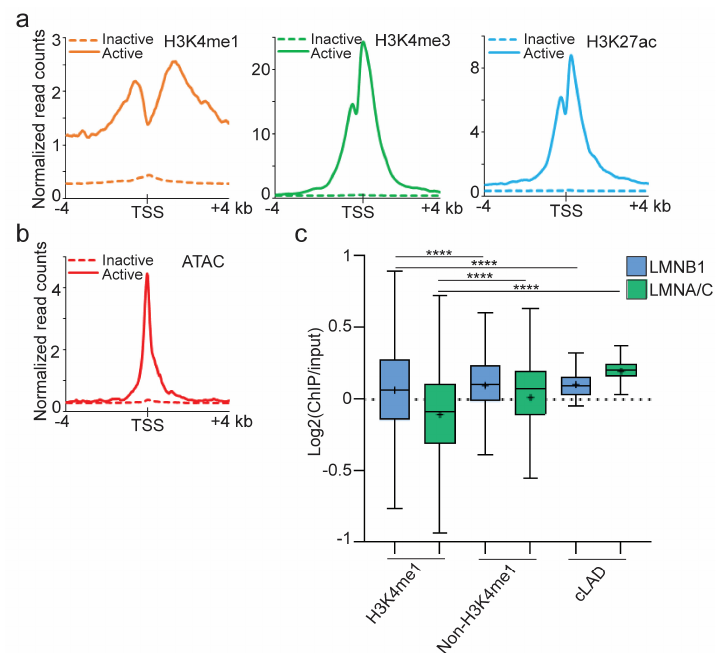
Figure 1. Adipogenic cLADs contain active gene regions. ( a ) H3K4me1, H3K4me3 and H3K27ac levels around the TSS of expressed (n = 244) and non-expressed (n = 3702) genes in cLADs; mean ChIP-seq read counts normalized to library size. ( b ) Chromatin accessibility around the TSS of cLAD genes, determined from published ATAC-seq data [37]. ( c ) LMNB1 and LMNA/C enrichment in H3K4me1 and non-H3K4me1 cLAD regions, and in whole cLADs; bar, median; cross, mean; box, 25–75% percentile; whiskers, min-max **** p < 10 − 4 , unpaired two-tailed t -test with Welch’s correction. A H3K4me1 region here is a cLAD region containing ≥ 1 H3K4me1 peak; LMNB1 and H3K4me1 data are from [10].